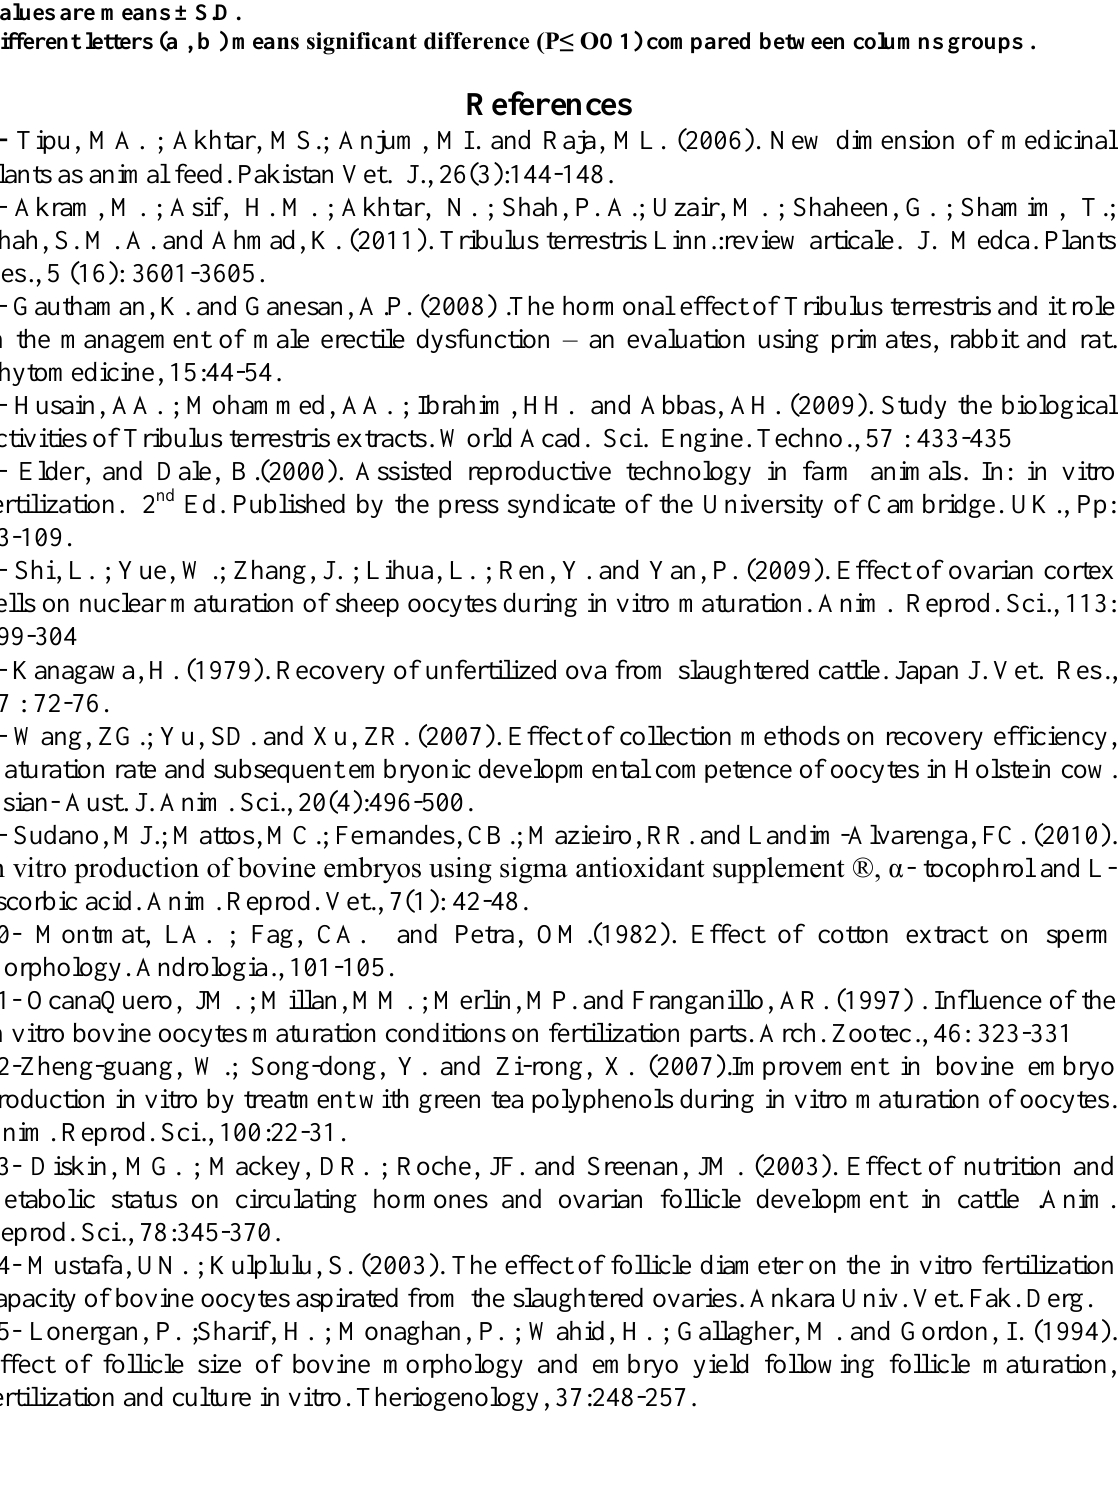
Values are means ±